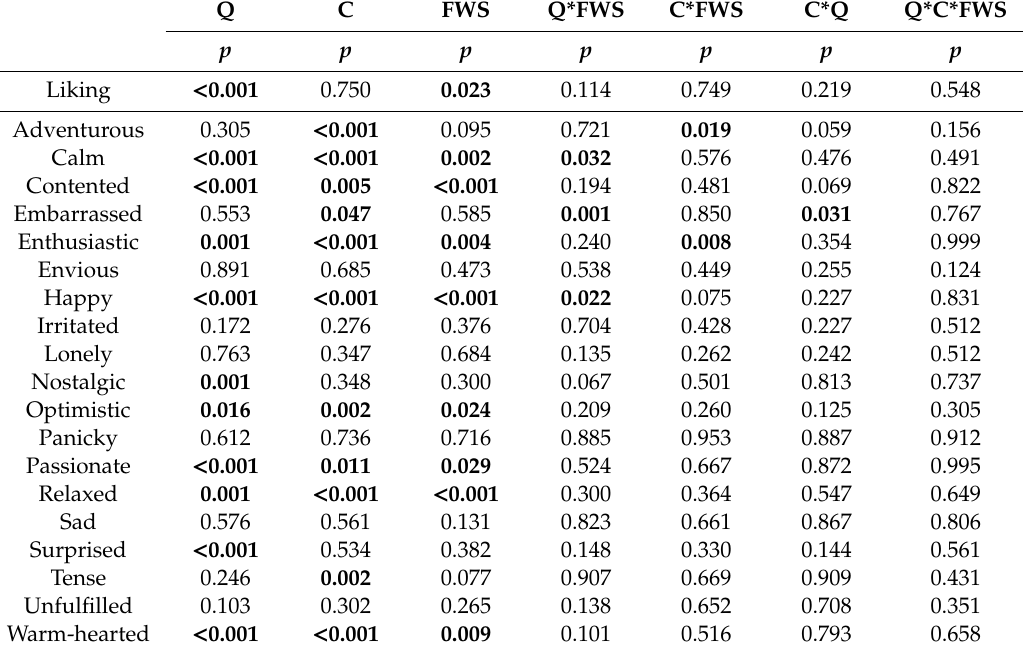
Table 4. Results of the Repeated Measures ANOVA investigating effects of quality (Q), context (C) and fine wine segments (FWS) on liking and reported product-evoked emotions for Study 2.